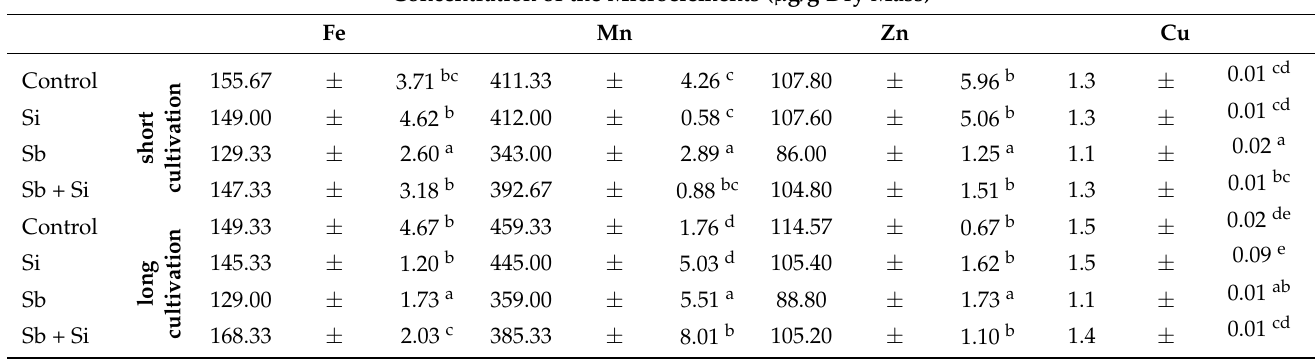
Table 3. Concentration of micronutrients ( µ g g − 1 dry mass) in the poplar calli after the short and long cultivations. The data are presented as the means ± standard error ( n = 3). Control—basal medium; Si treatment—basal medium + Si (5 mM); Sb treatment—basal medium + Sb (0.2 mM); Sb + Si treatment—basal medium + Sb (0.2 mM) and Si (5 mM). Different letters (a, b, c, d, e) denote statistically significant differences in the parameters between the treatments at p < 0.05 according to the Tukey